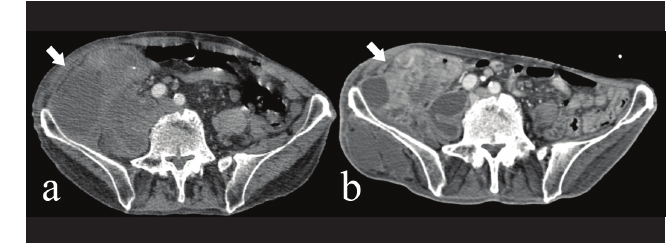
Figure 3 - Abscess formation (arrow) on pre-interventional CT (a) and the progression in abscess volume (arrow) on post- interventional CT (b) 20 days after percutaneous drainage in 36-year-old man with perforated appendicitis.